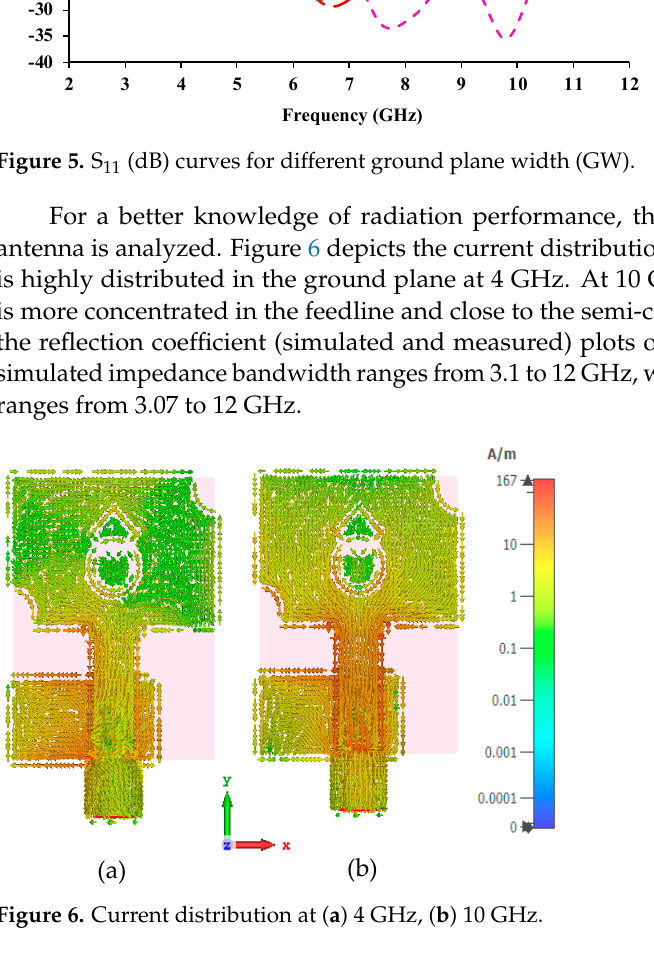
Figure 5. S 11 (dB) curves for different ground plane width (GW).